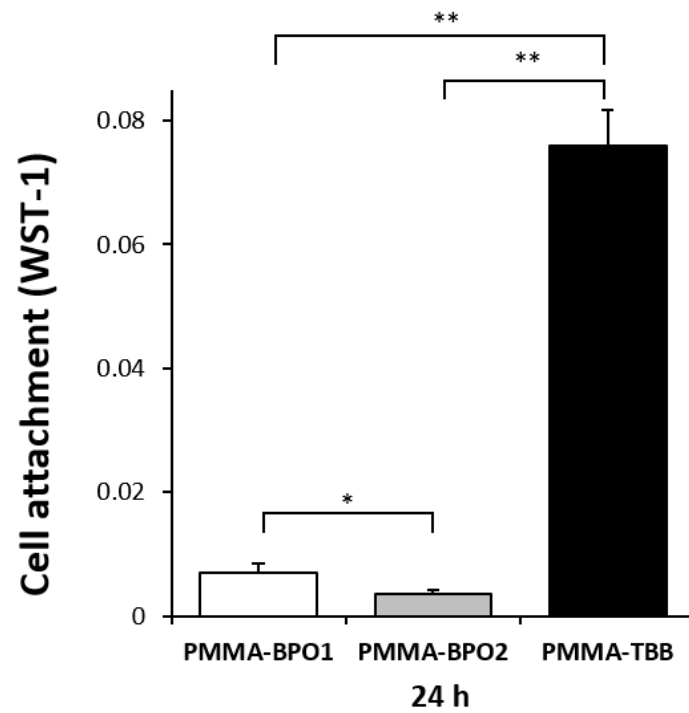
Figure 1. Attachment of osteoblasts on the three different bone cement surfaces during the initial stage of culture. The number of cells attached to each material surface during a 24-h incubation, evaluated using a water-soluble tetrazolium salts-1 (WST-1) assay. Each value represents the mean ± standard deviation of triplicate experiments ( n = 3). * p < 0.05, ** p < 0.01, one-way ANOVA followed by a Bonferroni test.